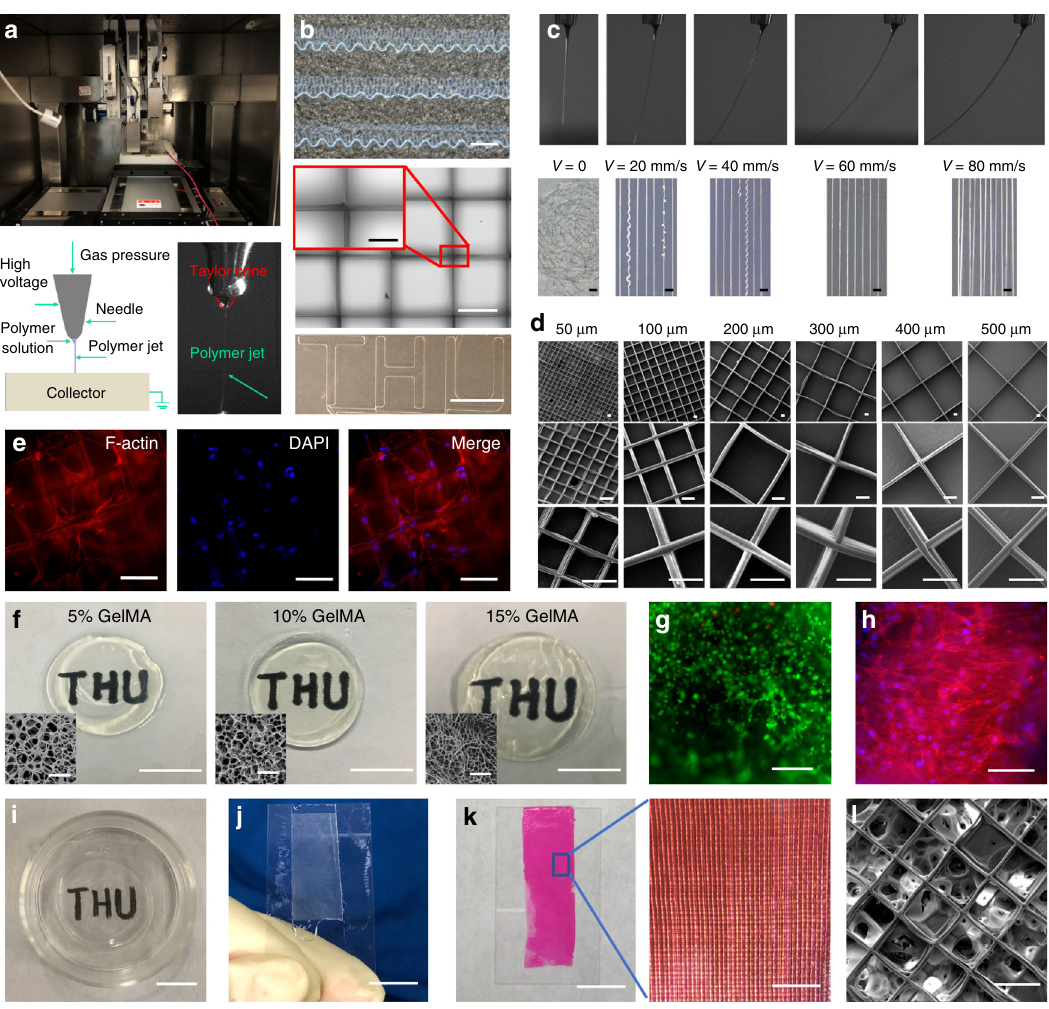
Fig. 1 Fabrication of characterization of the fi ber hydrogel. a The custom-made direct writing device, a schematic representation of direct writing, and a polymer jet being ejected from a Taylor cone. b Images of the obtained curly lines (Scale bar is 500 μ m), grids (Scale bar is 500 μ m and the enlarged image is 150 μ m), straight lines, and a speci fi cally designed pattern (Scale bar is 10 mm). c Images of stable jet deposition at different the moving speeds of the substrate in the speci fi c conditions. The scale bar is 100 μ m. d SEM images of the grid scaffolds with fi ber spacing of 50 – 500 μ m under different magni fi cation. The scale bar is 50 μ m. e LSSCs inoculated on the grid scaffolds can be induced to grow along the fi ber direction, cells were stained with phalloidin (red) and DAPI (blue). The scale bar is 100 μ m. f The macroscopic and microscopic morphology of the formed GelMA hydrogels with 5%, 10%, and 15% concentrations. The scale bar for macroscopic images is 10 mm, for the SEM images is 80 μ m. g The viability of LSSCs within the 5% GelMA hydrogel. Live cells are visualized with green, and dead cells appear red. The scale bar is 500 μ m. h The cytoskeleton (red) and DAPI (blue) staining of LSSCs within the 5% GelMA hydrogel. The scale bar is 100 μ m. i – l The fabricated 100 μ m spacing grid fi ber-reinforced GelMA hydrogel. The scale bar in i – k is 10 mm, the enlarged image in k is 1 mm, l is 100 μ m. The staining in e , g , and h were repeated three times independently with similar